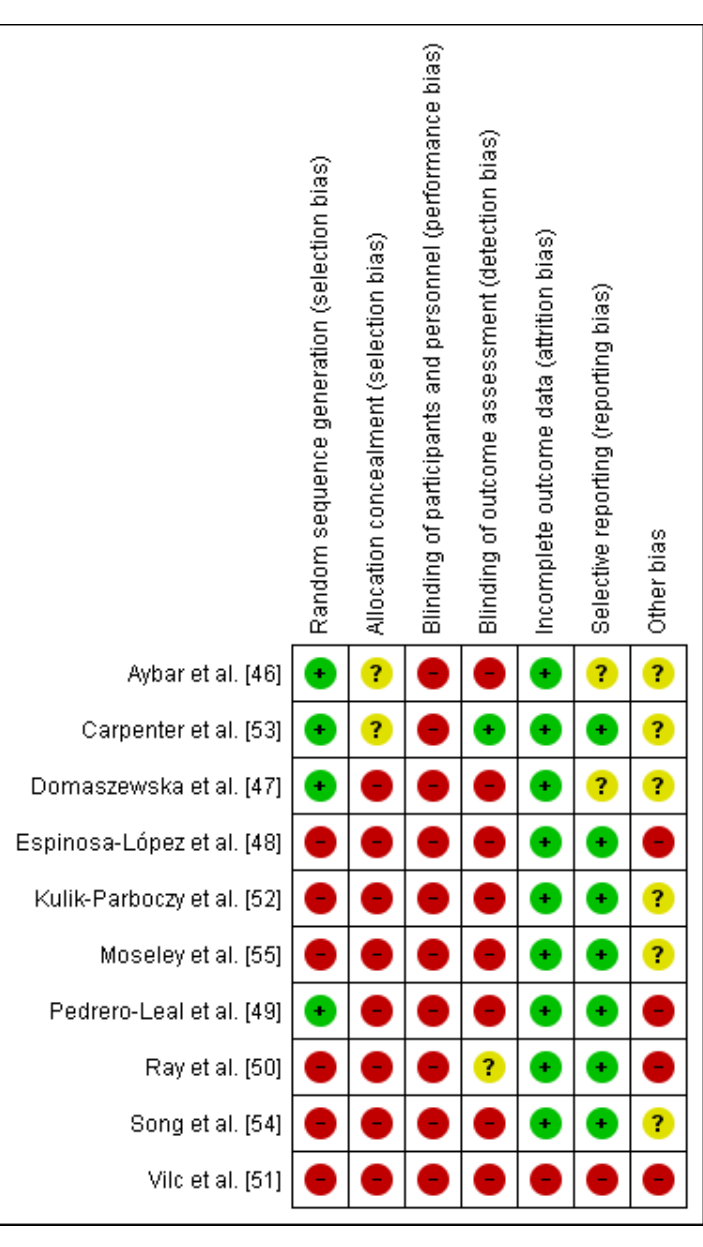
Figure 2. Risk of bias summary [46–55].